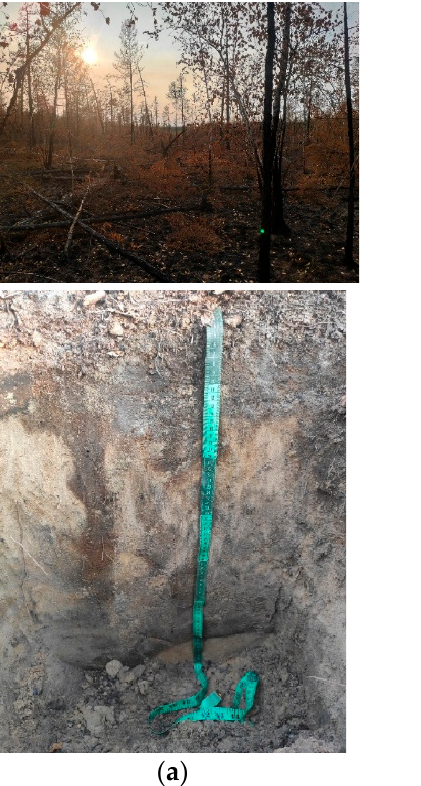
Figure 2. Photo of plots and studied soils: ( a ) burned plot; ( b ) control plot. Table 1. Characteristics of studied soils. Plot